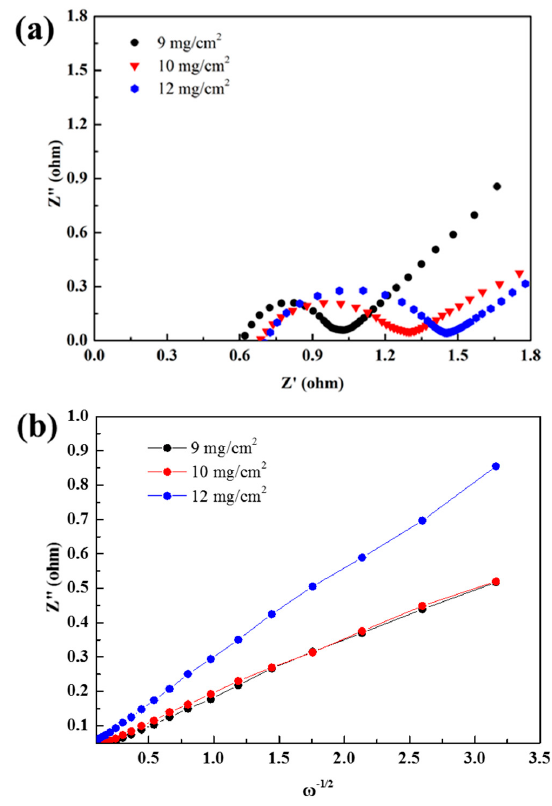
Figure 4. ( a ) Electrochemistry impedance spectra (EIS) curves with graphite loading; and ( b ) relationship between Z” and ω − 1/2 of the related EIS plots. The EIS measurement of the Al batteries was analyzed under charging at 2.5